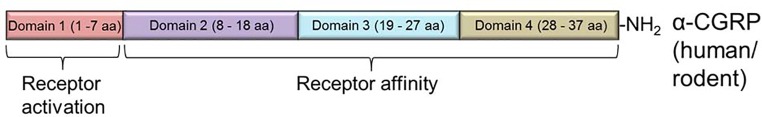
Domain structure of α-CGRP neuropeptide in rodent and human. The peptide is composed of four domains (Domain 1 to Domain 4). Domain 1 is essential for the CGRP receptor activation, while Domains 2–4 are necessary for receptor affinity.